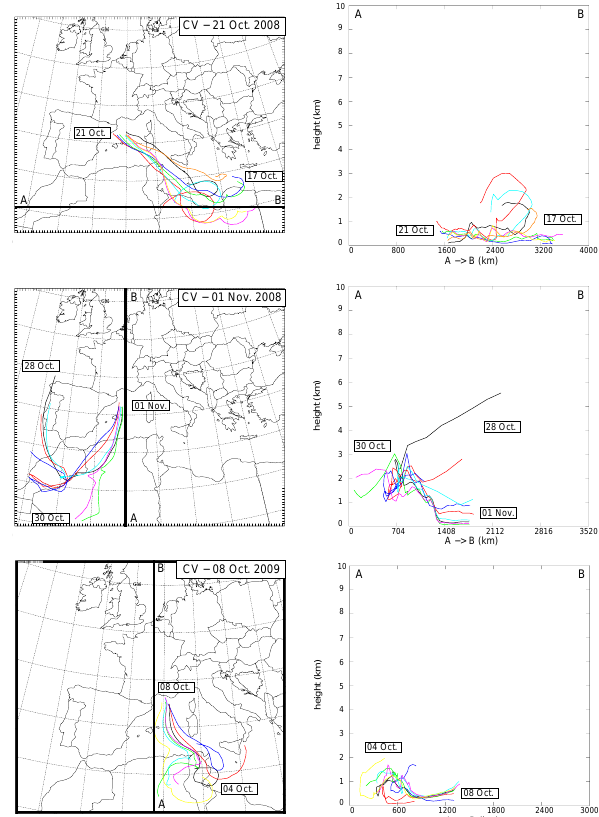
Fig. 13. Backward trajectories of some air parcels taken in the moist feeding flow obtained with the RAI10 simulation for three CV cases: the 12 August 2008 (top), the 3 September 2008 (middle) and the 20 October 2008 (bottom). The backward trajectories are projected both on an horizontal plane (left panels) and on a vertical cross-section (right panels). The vertical cross-section follows the line AB displayed on the left planels.